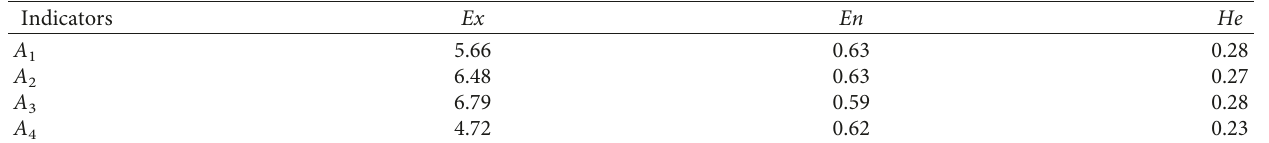
Table 8: First-level indicators of section ZK71+175 ∼